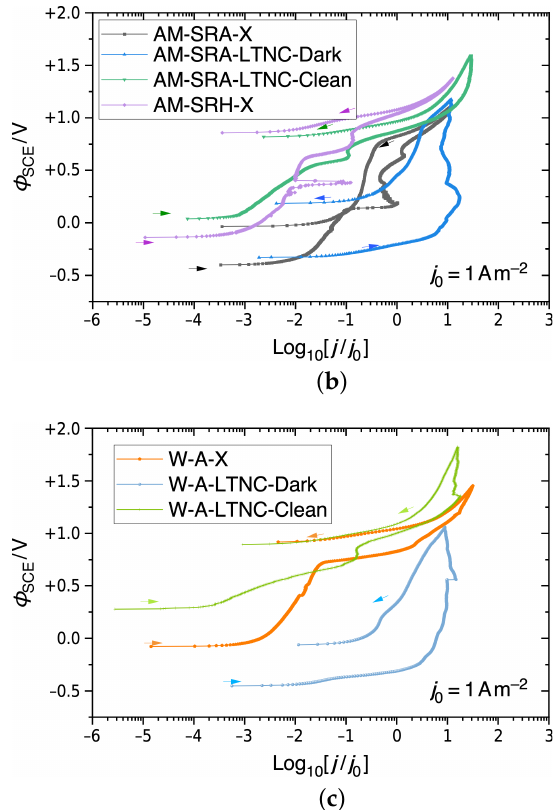
Figure 9. CPP results for Alloy 22 in 5M CaCl 2 at 393K, shown as semi-logarithmic plots of φ SCE , the electrostatic relative to an SCE, against the decadic logarithm of the current density j relative to a unit current density. ( a ) Non-treated AM Alloy 22. ( b ) Non-treated and LTNC-treated AM Alloy 22. ( c ) Non-treated and LTNC-treated wrought Alloy